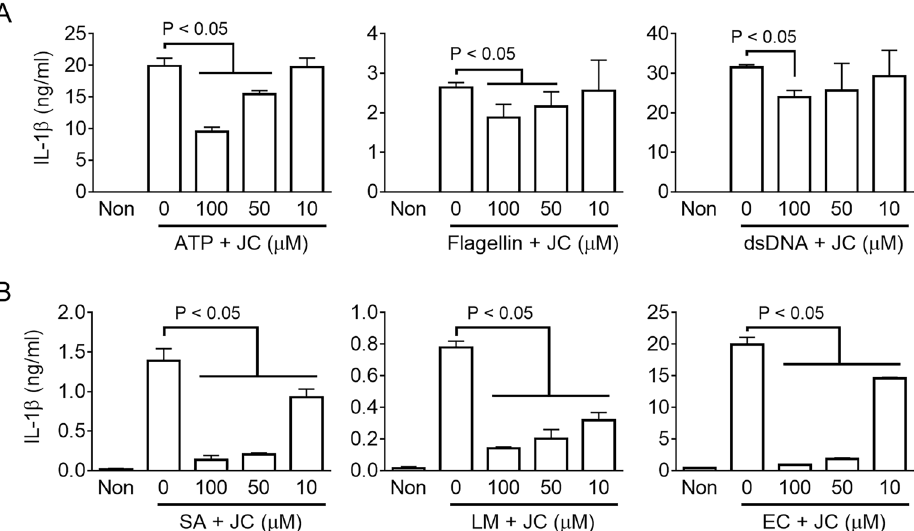
Figure 2. Effects of JC on NLRC4 and AIM2 inflammasomes. ( A ) LPS-primed BMDMs were treated with ATP, flagellin, and dsDNA to activate NLRP3, NLRC4, and AIM2 inflammasomes in the presence of JC, as indicated. ( B ) LPS-primed BMDMs were treated with JC, and inoculated with Staphylococcus aureus (SA), Listeria monocytogenes (LM), and Escherichia coli (EC). The secretion of IL-1β was measured by ELISA. The bar graph presents the mean ± SD with at least three independent